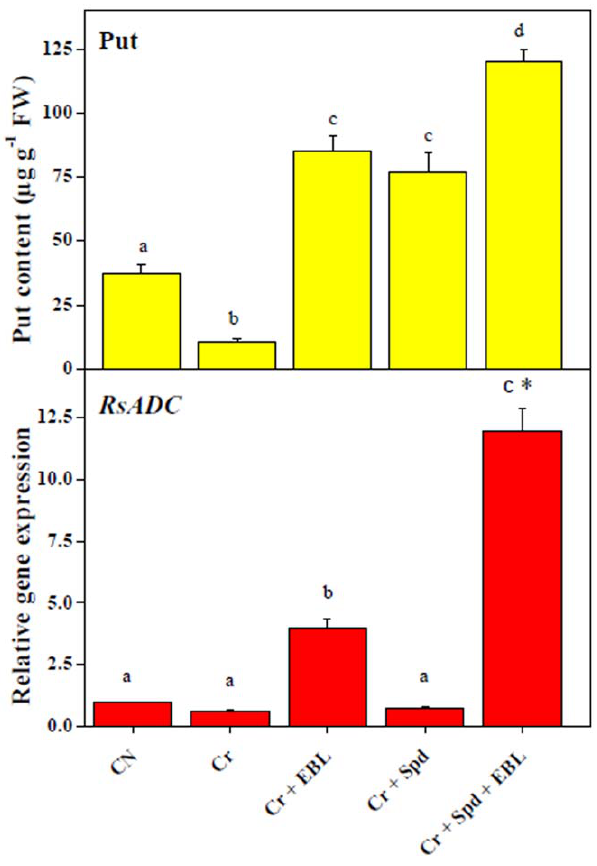
Figure 2. Endogenous levels of Spd ( m g g 2 1 FW) and relative expression of RsSPDS in 7-d-old radish seedlings under Cr- stress without or with EBL and/or Spd. Data are presented as mean 6 SE. Different superscripted letters (a, b, c) indicate significant difference from each other in all combinations (Tukey’s test, p , 0.05). Asterisk ‘‘*’’ indicates significant difference for EBL + Spd vs. EBL under Cr-stress (Tukey’s test, p , 0.05).